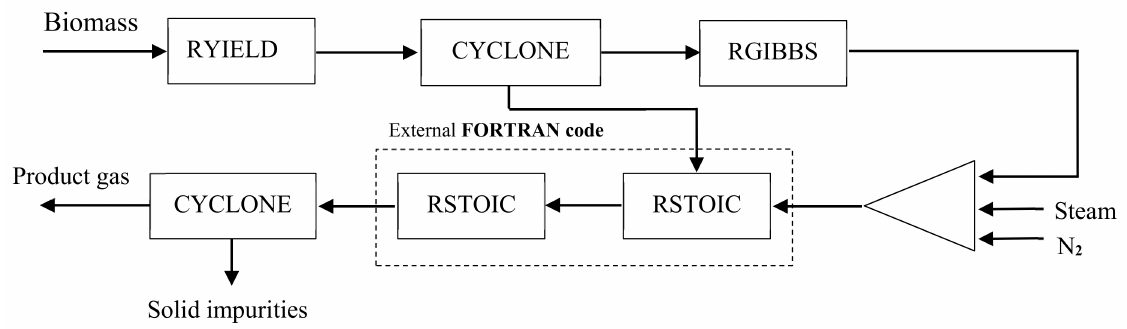
Figure 2. Biomass gasification model flow chart in Aspen